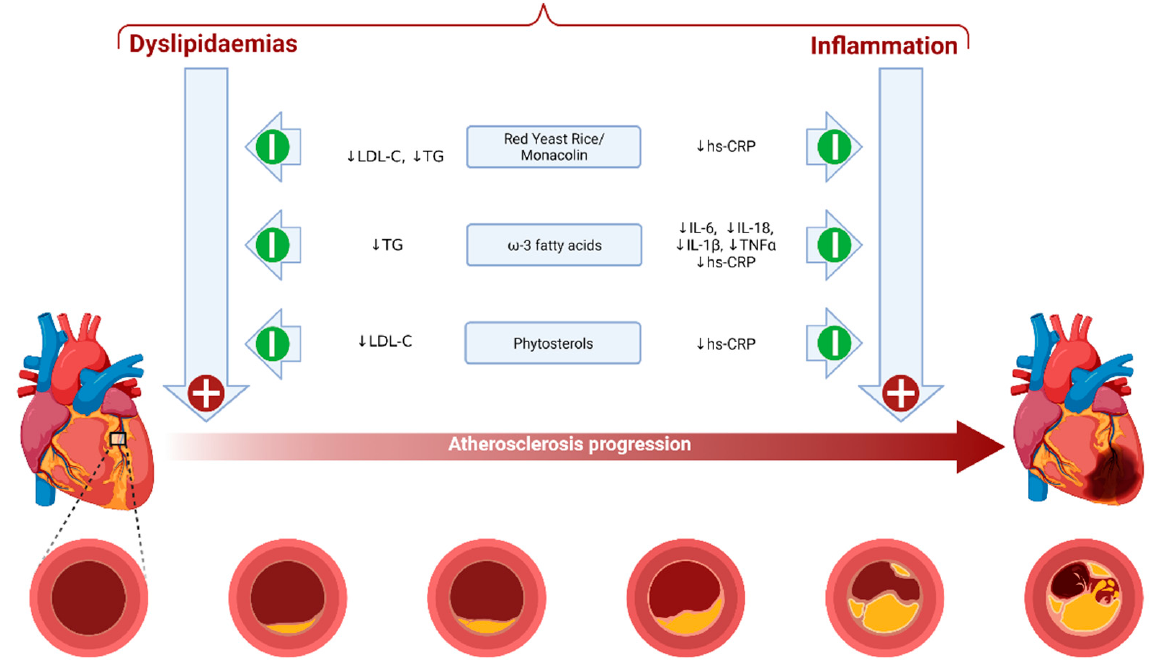
Figure 1. Summary of biological mechanisms involved in the anti-atherosclerotic actions of key evidence-based nutraceuticals. Image Adapted from “Atherosclerosis Progression”, by BioRender.com (2021). Retrieved from https://app.biorender.com/biorender-templates (Accessed date: 23 July 2021).